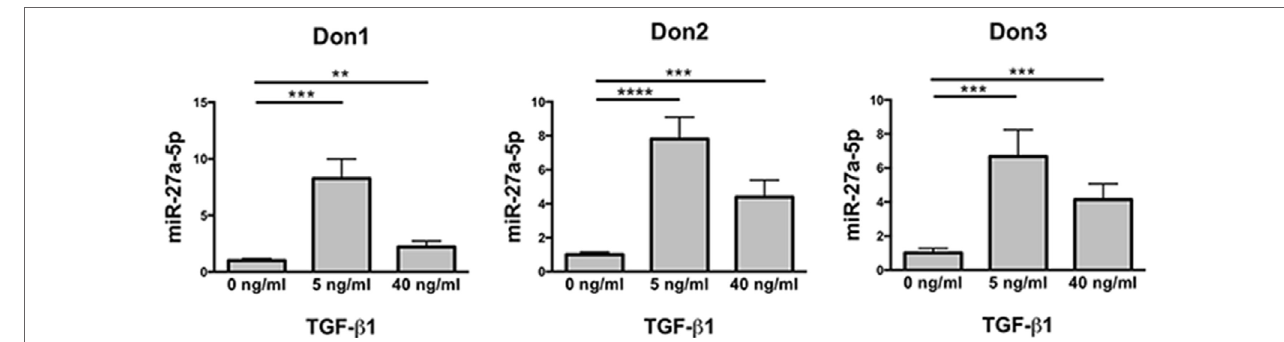
FigUre 2 | Expression profile of miR-27a-5p in TGF- β 1-treated natural killer (NK) cells. NK cells untreated or treated for 24 h with the indicated concentration of TGF- β 1 were analyzed for miR-27a-5p expression. RNU44 was used as reference control. Experiments were performed in quadruplicate on NK cells derived from three healthy donors (donors 1, 2, and 3). Expression relative fold changes are referred to the expression of untreated cells, whose miR-27a-5p expression has been arbitrarily assigned the value 1. ** p < 0.01, *** p < 0.001, and **** p <